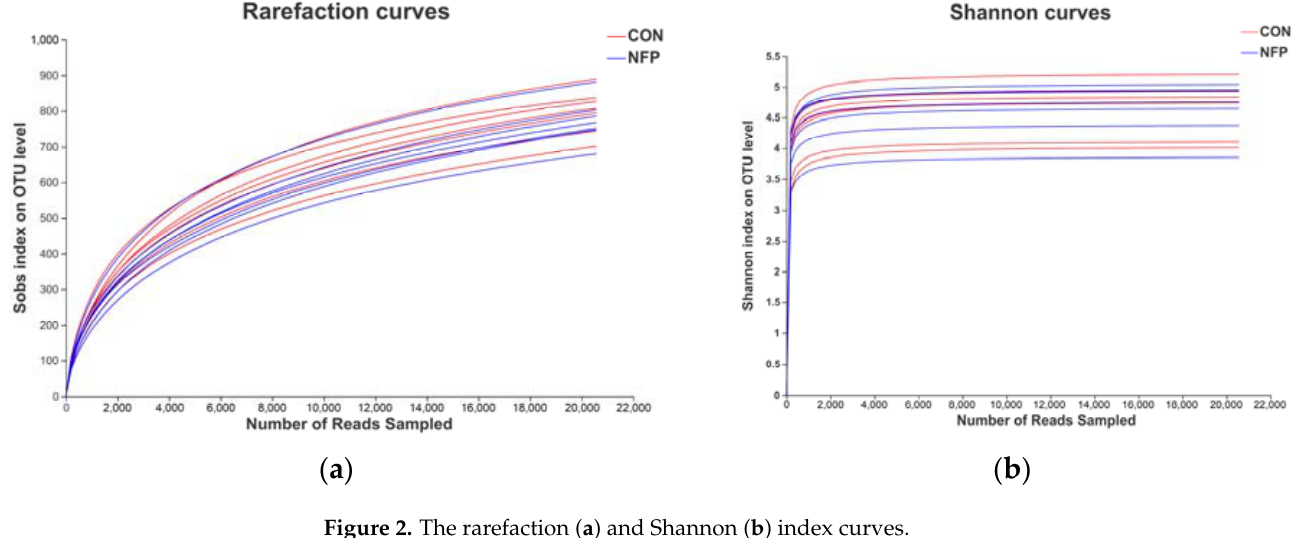
Figure 2. The rarefaction ( a ) and Shannon ( b ) index curves.